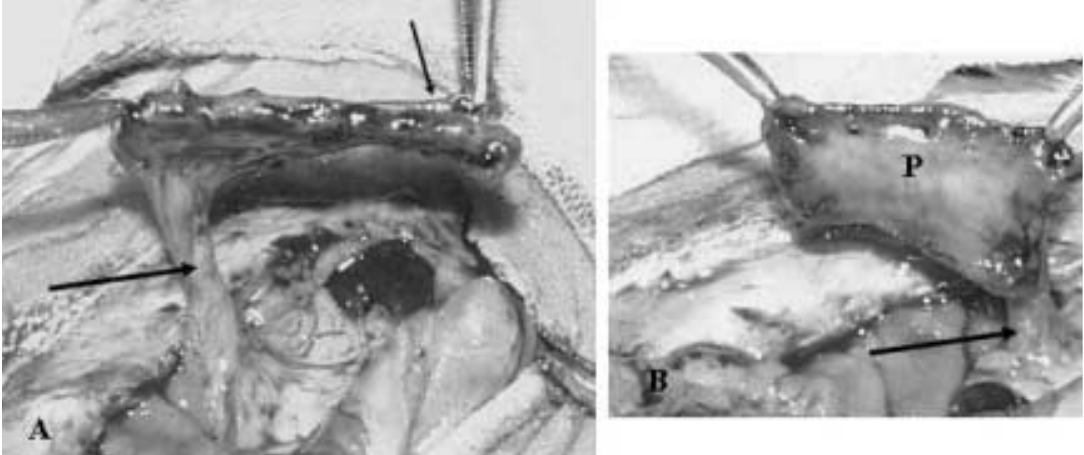
A. OPMP flap over- laid by silicon graft (arrow) was mo- bilised from the abdominal wall. B. The silicon graft was removed from the peritoneal (P) side of the flap con- sisting of abdominal wall muscle and peri- toneum based on the omentum